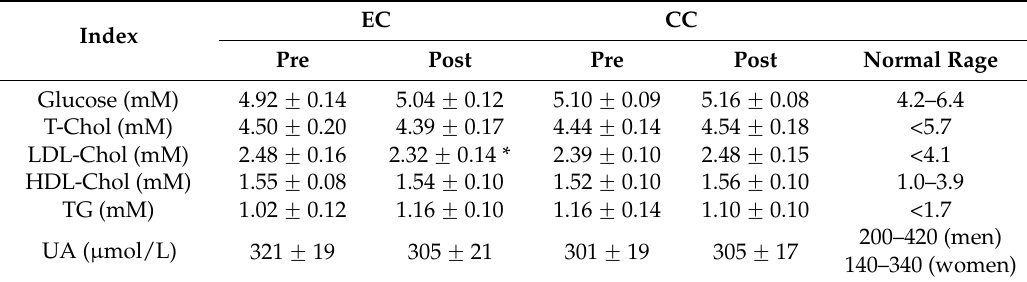
Table 4. Metabolic parameters following polyphenol-enriched (EC) and plain (CC) yogurt consumption (Mean ˘ SEM).